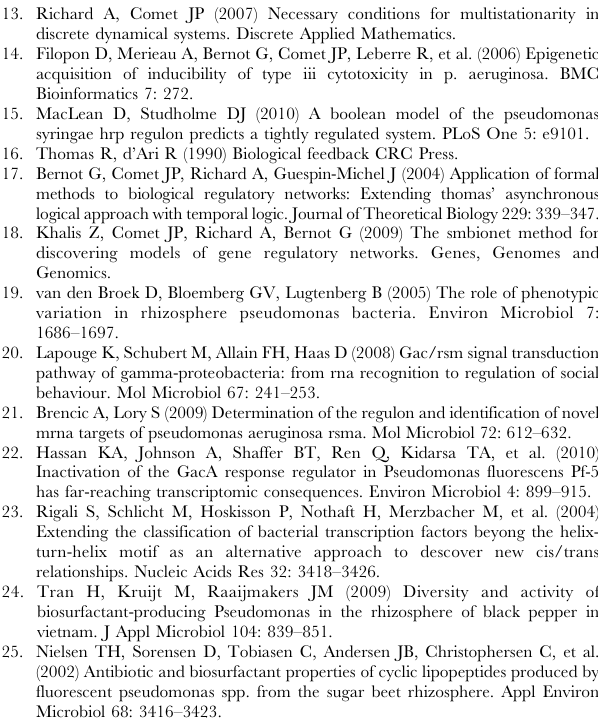
Figure S1 The 12 Boolean networks f with three components ( c , r and b ) that are consistent with property P and with an interaction graph in which b has no outgoing interaction. The graphical conventions used to described the interaction graph of each network are as follows: arrows of form { w correspond to positive interactions; arrow of form { j correspond to negative interactions; and arrows of form { w j indicate the presence of both positive and negative interaction. Asynchronous state graphs are represented in a 3D- grid, with c in the vertical axis (first component), r in the horizontal axis (second component), and b in the third axis (third